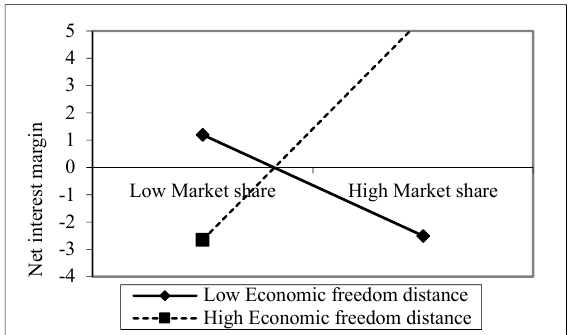
Figure 3. Market Share × Economic Freedom Distance.